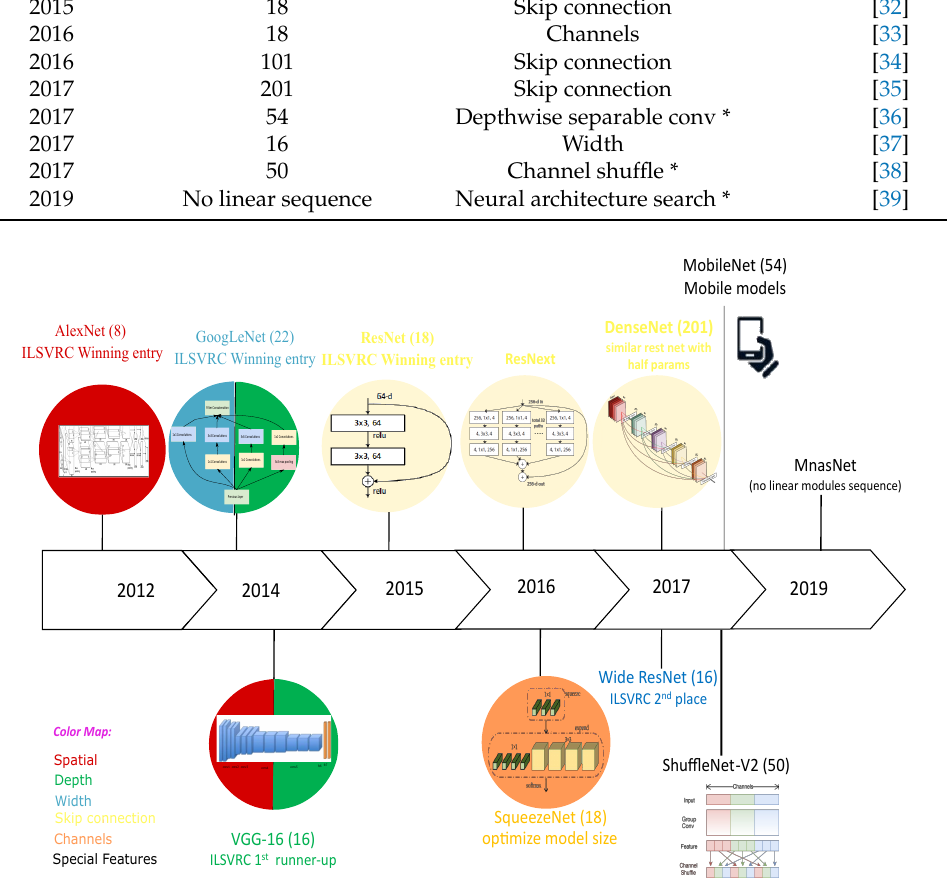
Figure 1. Infographic of the tested pre-trained models. Each model is introduced with its architecture symbol, the number of layers between brackets, and design specification (see the color